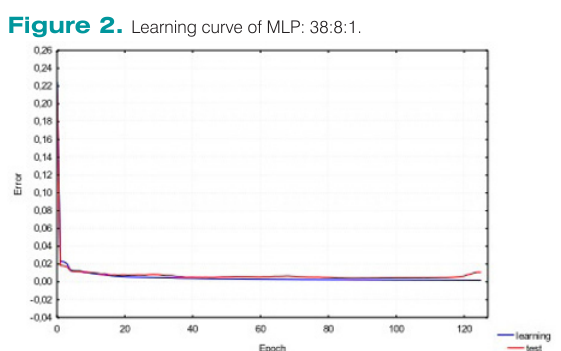
antifungal data for a) learning R = 0.9461, RMSEP = 0.4047; b) validation R = 0.9060,RMSEP = 0.5633; c) testing set R = 0.8824, RMSEP =